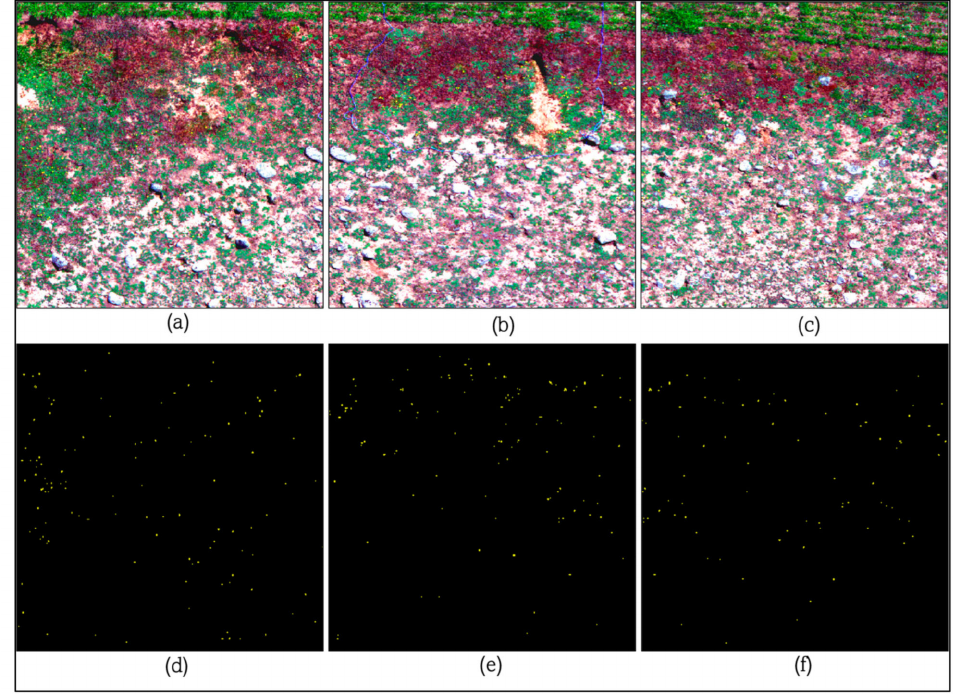
Figure 11. Prediction results (EPSG:4326—WGS 84) ( d – f ) of XGB model within a large area of the study site for ( a ), ( b ), and ( c )